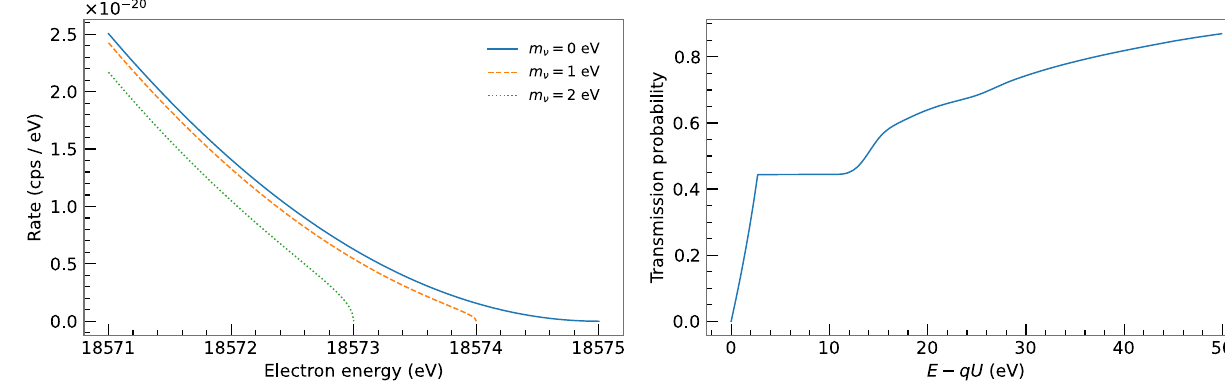
Fig. 1 Left: impact of non-zero neutrino mass on the differential β - spectrum. The smoking gun is the change in curvature near the end- point. Right: transmission probability of electrons depending on their surplus energy at a retarding potential of qU = 18 , 575eV. The sharp